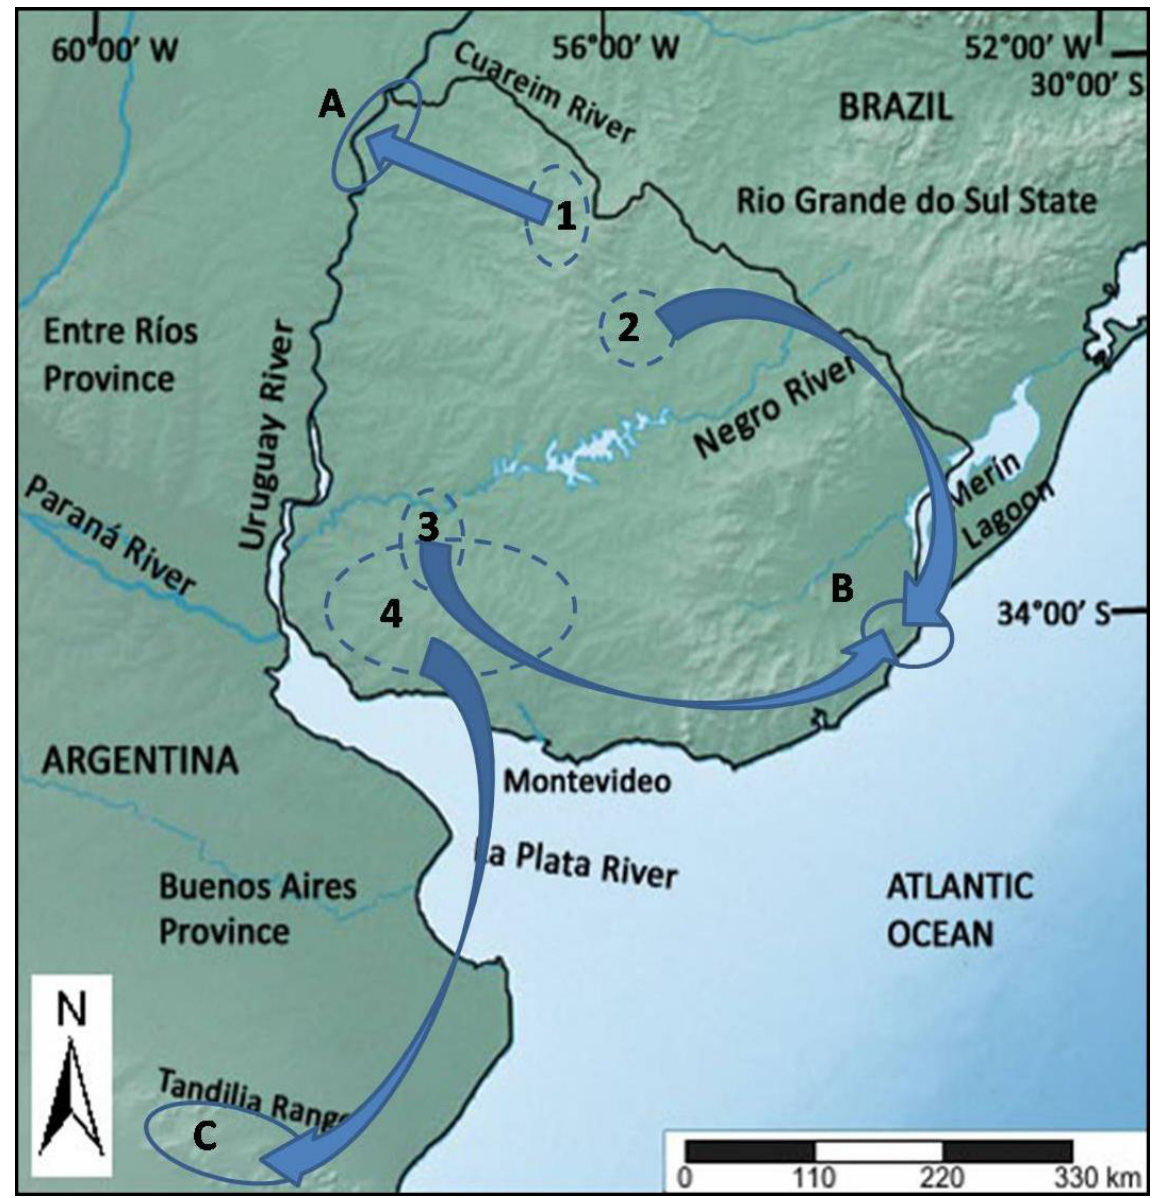
Figure 3. Raw material long distance transfers (>100 km) suggested for early hunter-gatherers in Uruguay. Circles and letters indicate areas with residential sites: A. Middle Uruguay River and Lower Cuareim River; B. Negra Lagoon basin; C. Tandilia Range. Dashed line circles and numbers indicate proposed source areas: 1. Catalanes-Arapey region; 2. Yaguarí Creek gravel deposits; 3. Grande Creek basin; 4. Southwest Uruguay. Arrows indicate proposed transfer distances: 1-A, for silicified sandstone and translucent agate (Suárez 2010; 2011b); 2-B and 3-B, for chalcedony and silicified limestone (López Mazz et al . 2011, but see discussion in the same article); 4-C, for silicified limestone (Flegenheimer et al .